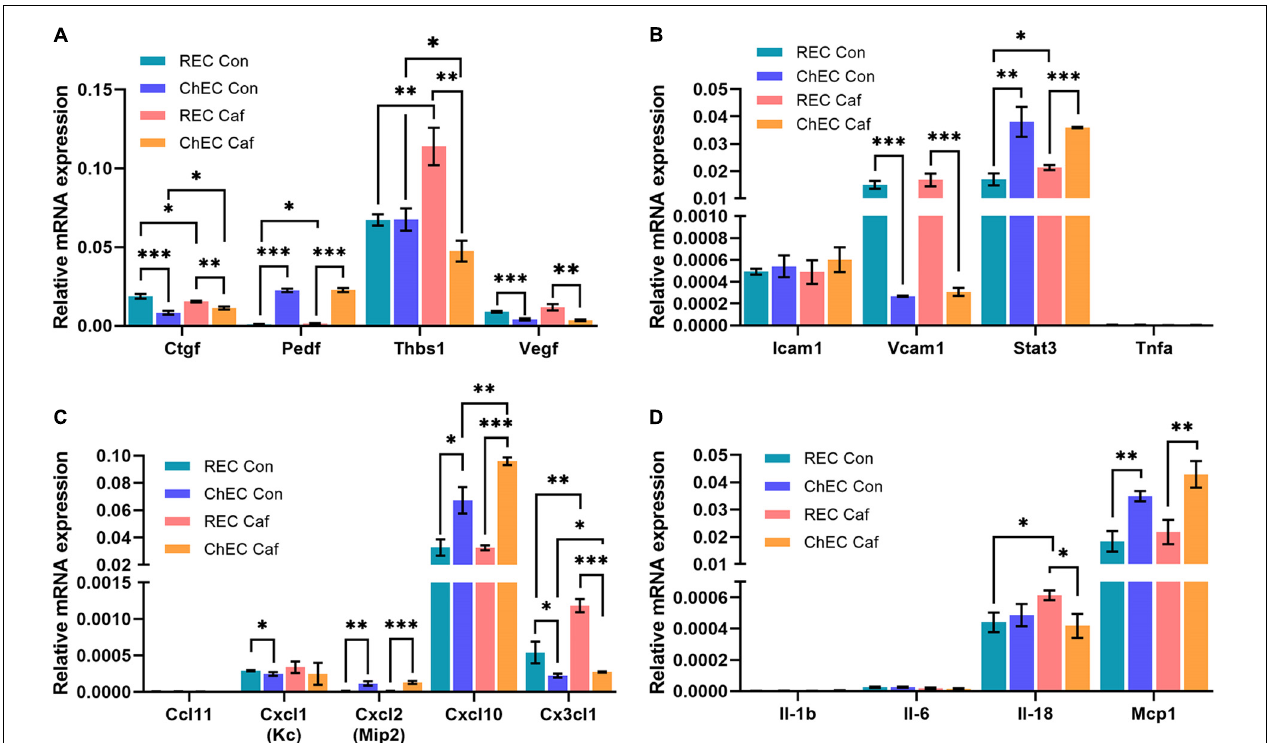
FIGURE 6 | Expression of pro- and anti-angiogenesis and inflammatory mediators in retinal (REC) and choroidal endothelial cells (ChEC) incubated with caffeine. The expression levels of various factors that modulate angiogenesis and inflammation was assessed by qPCR analysis including (A) angiogenesis and inflammatory genes, (B) cell adhesion molecules (C) chemokines, and (D) cytokines. These experiments were done in triplicate and repeated with RNA from two different isolations retinal and choroidal EC ( ∗ p < 0.05; ∗∗ p < 0.01; ∗∗∗ p < 0.001). RpL13A, 60S ribosomal protein L13a was used as control. Please note a